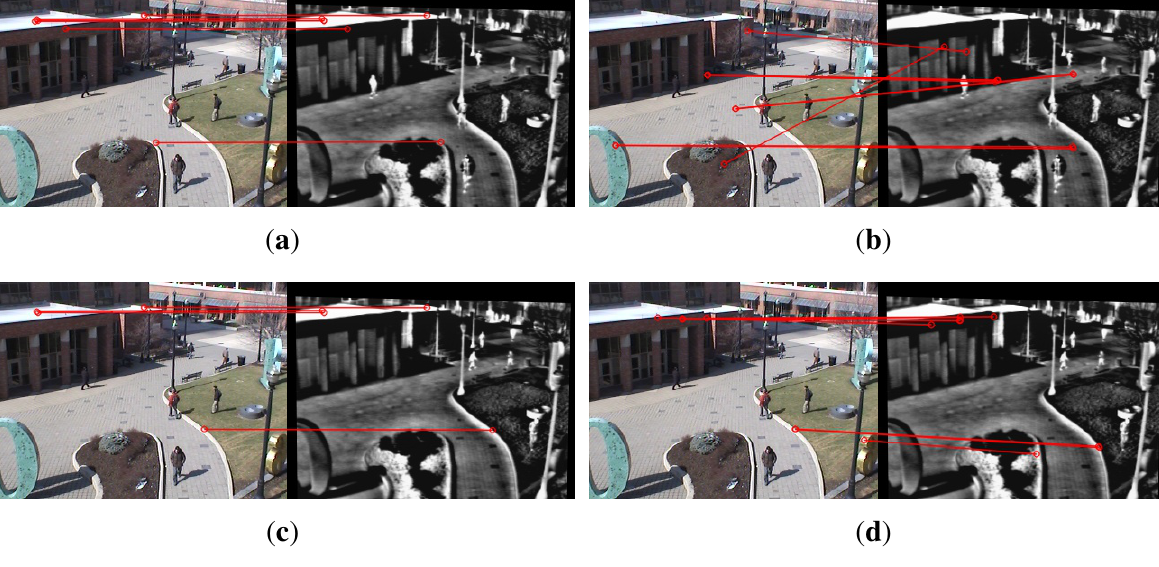
Figure 8. Matching results on two image pairs from the OSUColor and Thermal